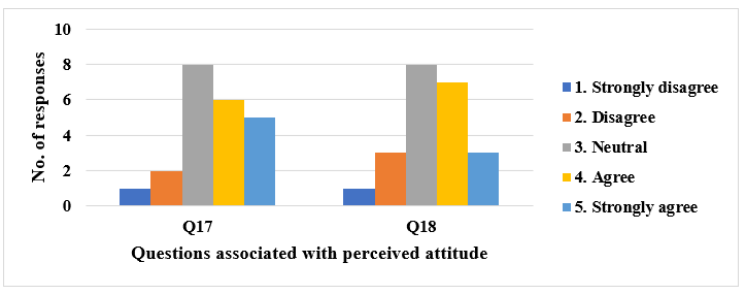
Figure 7. Number of responses for items related to PA.